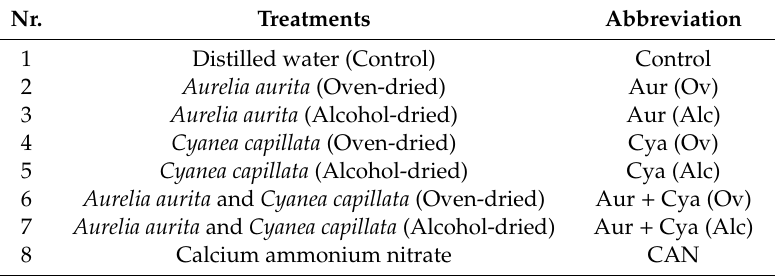
Table 2. Petri plate experiment treatments.